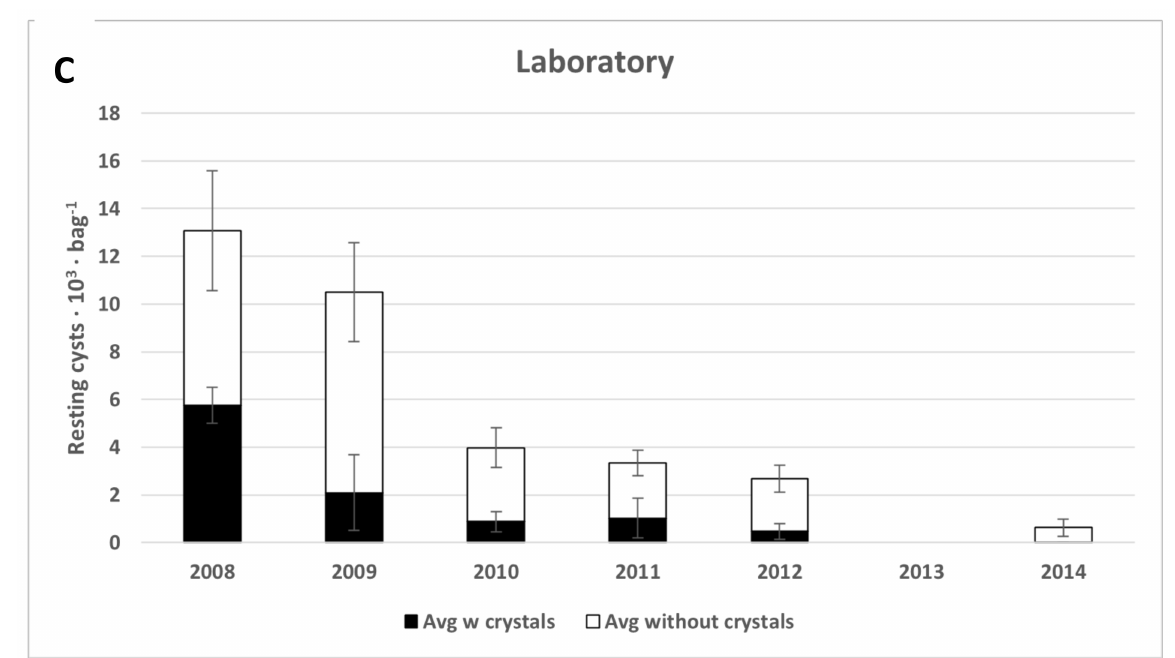
Figure 7. The total number of Scrippsiella spp. cysts with (black) and without (white) crystals. ( A ) oxygenized, ( B ) anoxic, and ( C ) refrigerated (test tube) environments. Error bars are the standard error of the mean.